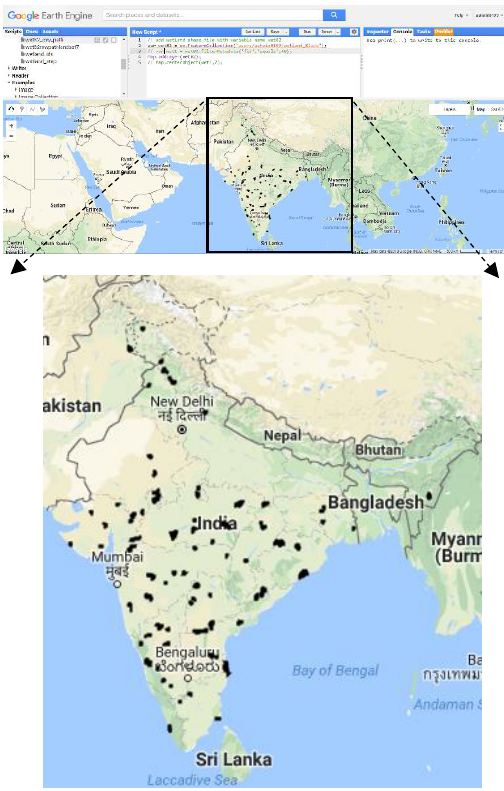
Figure 1: Large wetlands of India shown in the Google earth engine. GEE platform comprises of scripts,